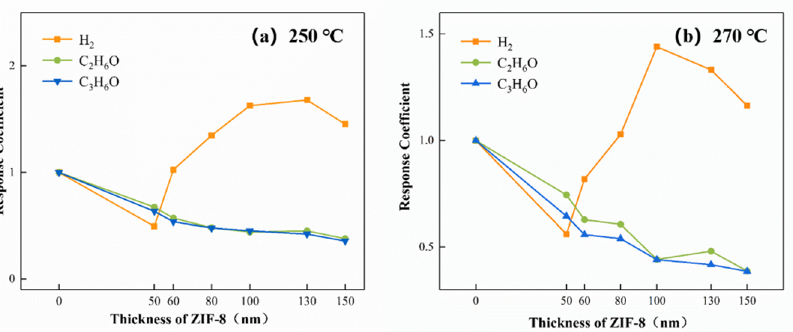
Figure 15. The response coefficients vs. the thicknesses of the ZIF-8 curve at ( a ) 250 °C and ( b ) 270